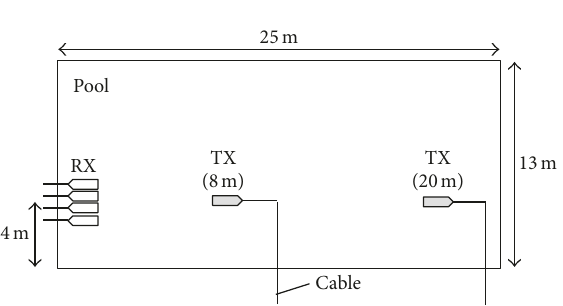
Figure 13: Location of transmitter and receiver